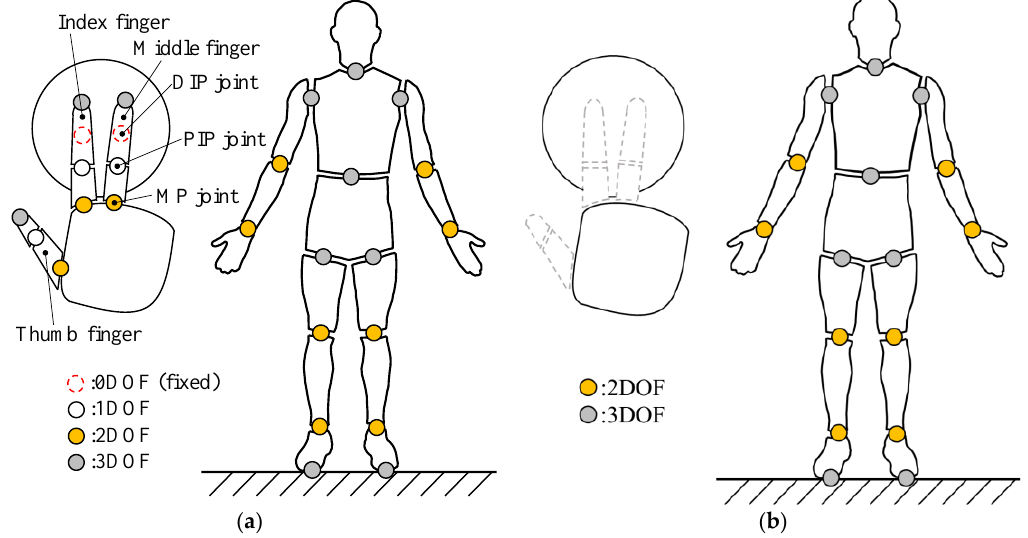
Figure 1. A schematic representation of whole body and ball model: ( a ) model with finger segments (22-segment model); ( b ) model without finger segments (16-segment model). The distal and middle segments of index and middle fingers are treated as one segment in the